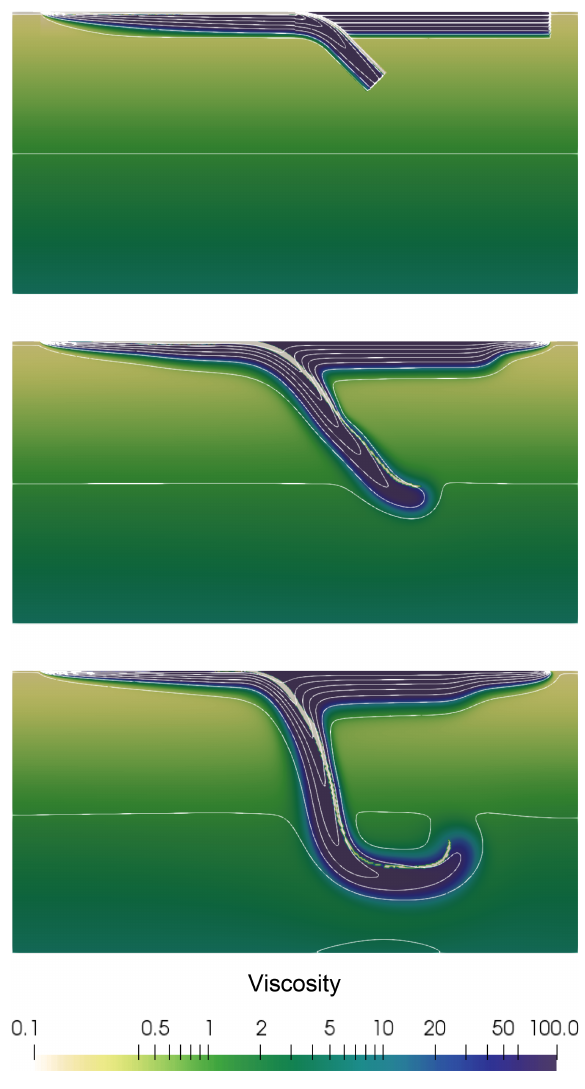
Figure 5. Dimensionless viscosity field in log scale superimposed with 10 (dimensionless) temperature (between 0 and 0.82) isocon-